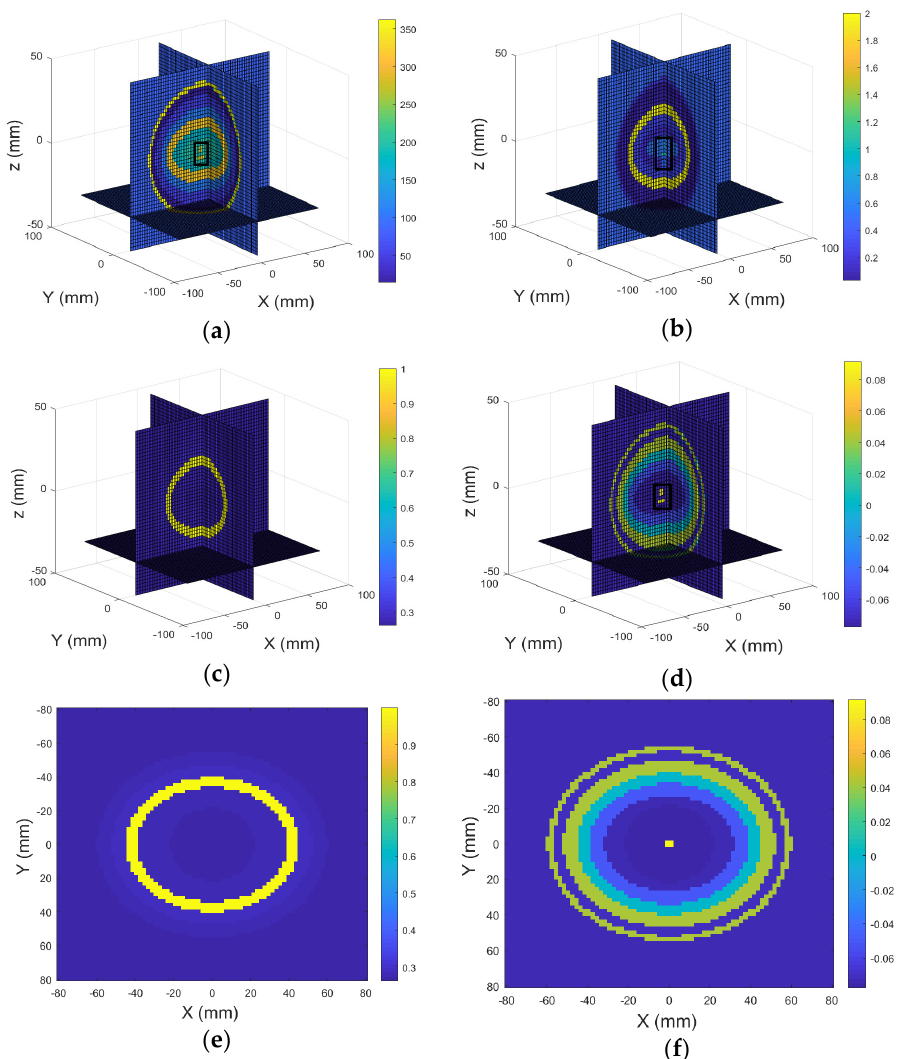
Figure 7. 3D view of the head model contains two lesions: ( a ) Real part; ( b ) Imagery part; 3D reconstructed images of the head model contains two lesions: ( c ) Real part; ( d ) Imagery part; 2D reconstructed image: ( e ) Real part; ( f ) Imagery part.